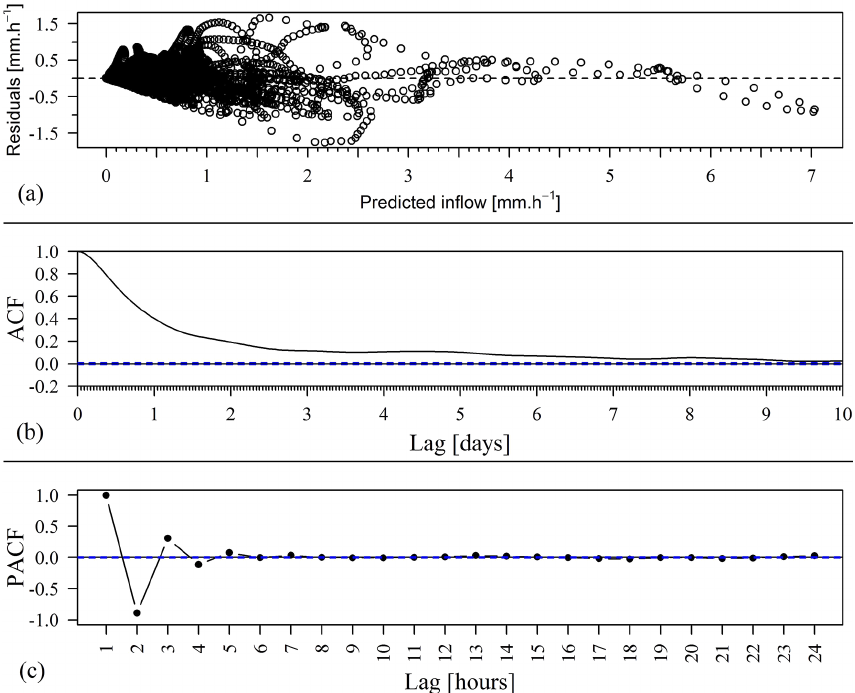
Figure 4. Plots of (a) residuals from the conceptual model as a function of predicted inflow during the calibration period, (b) autocorrelation function of the residuals, and (c) partial autocorrelation functions of the